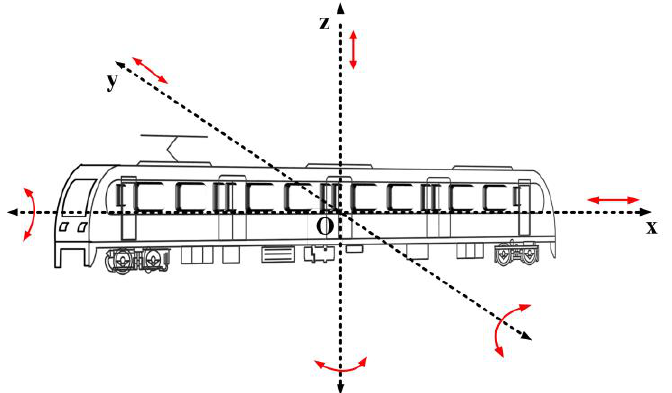
Figure 2. Schematic diagram of train vibration form.